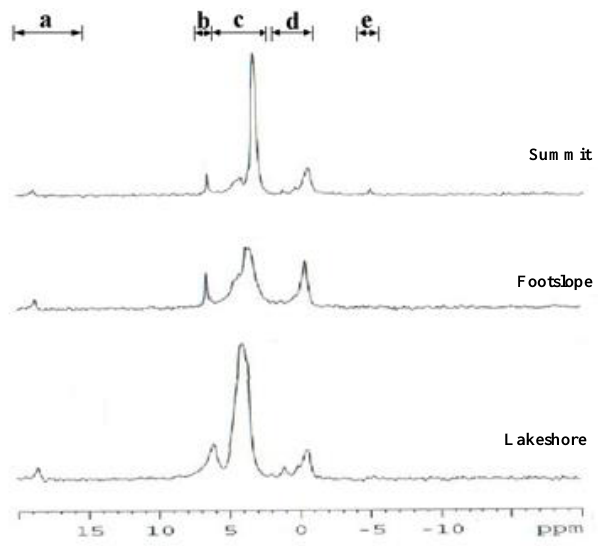
Figure 3. 31 P-NMR spectra for NaOH-EDTA extracts from soils at different sites. a: phosphonate, b: inorganic orthophosphate, c: orthophosphate monoesters, d: orthophosphate diesters, e: pyrophosphate.